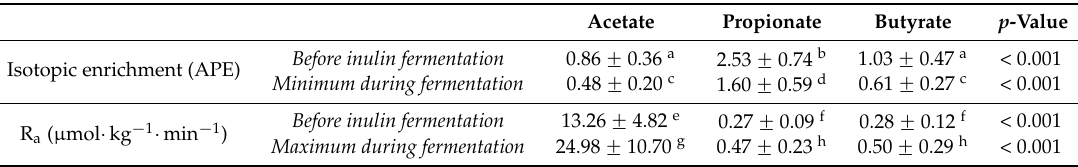
Table 3. The enrichments and rate of appearances (R a ) of acetate, propionate, and butyrate in plasma in healthy subjects before and during inulin fermentation. (APE: atom percent excess).